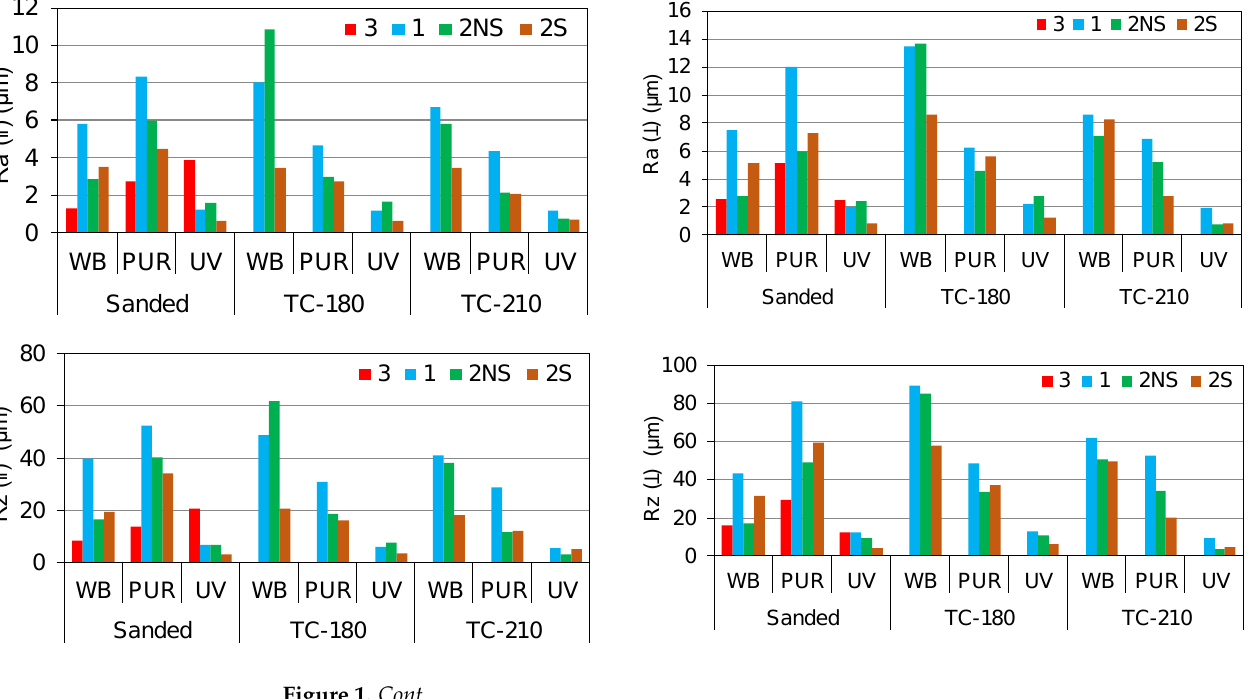
Table 1. Analysis of variance of surface roughness for sanded and thermally compressed veneers. Source of Variation